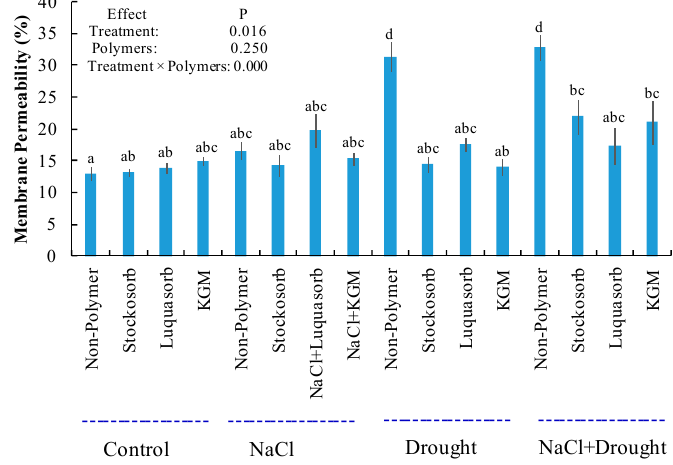
Figure 2. Effect of drought and salt stress on leaf membrane permeability in Metasequoia glyptostroboides seedlings supplemented with synthetic (Stockosorb, Luquasorb) and natural (Konjac glucomannan, KGM) hydrophilic polymers along with plants not amended with polymers (Non-Polymer). Each column represents the mean of three to five individual plants and bars represent the standard error of the mean. Columns labelled with different letters (a, b, c, and d) are significantly different at the p < 0.05 level.